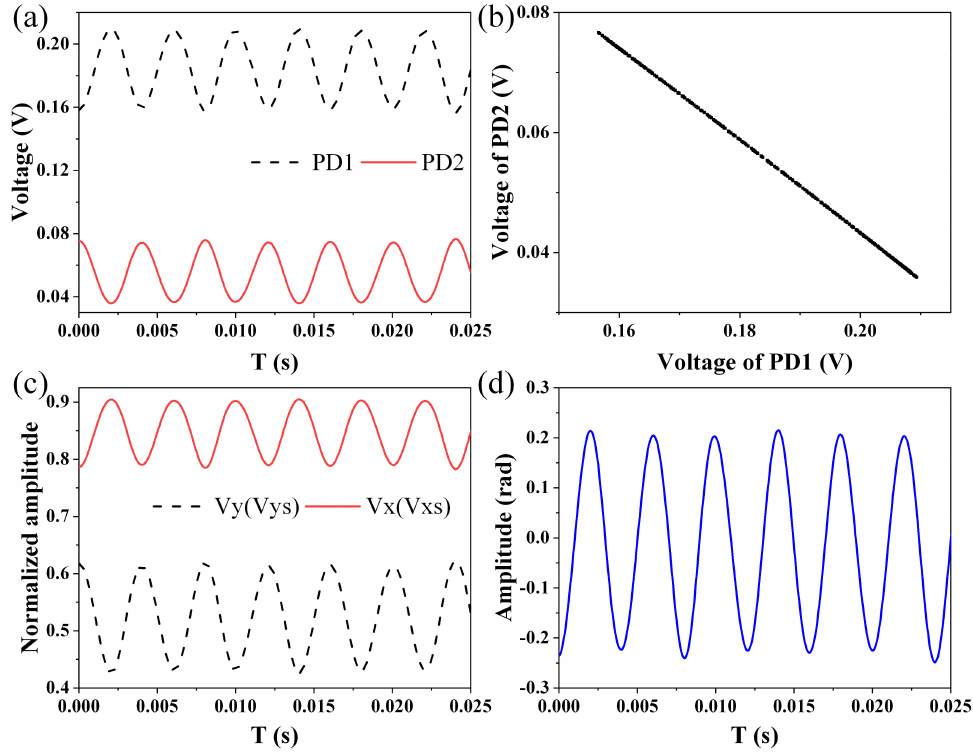
Figure 3. Experimental results in small signal condition. ( a ) Output signals from two photodetectors. ( b ) Scatter diagram of output signals. ( c ) Orthogonal signals. ( d ) Demodulation phase